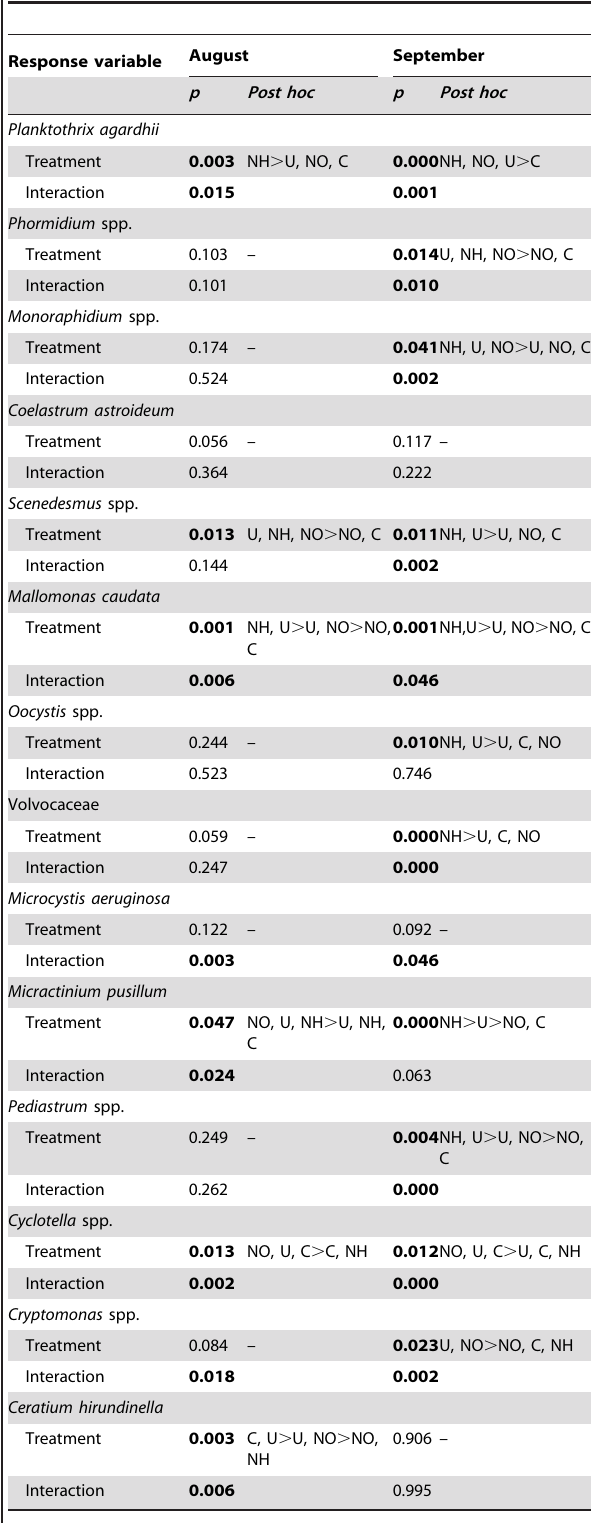
Table 2. Repeated-measures analysis of variance for the response of selected phytoplankton taxa to added